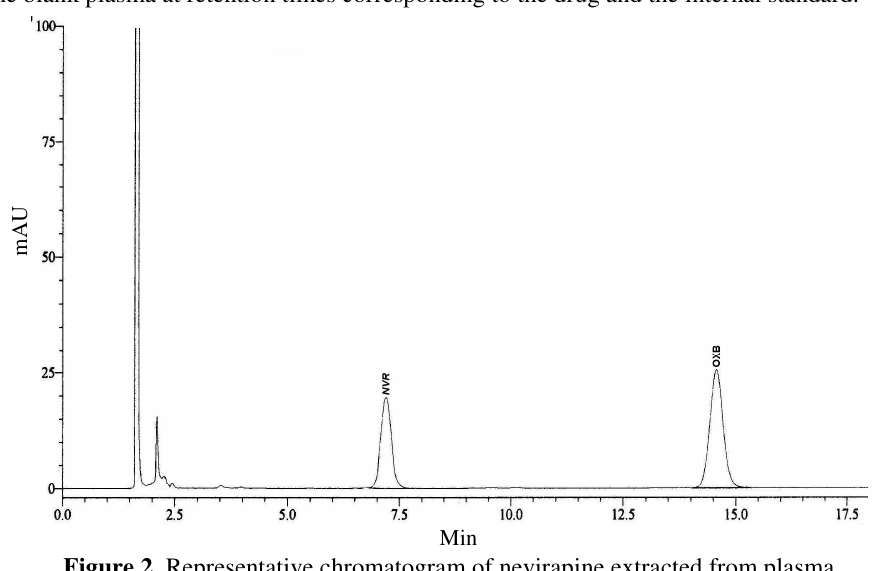
Figure 2. Representative chromatogram of nevirapine extracted from plasma.